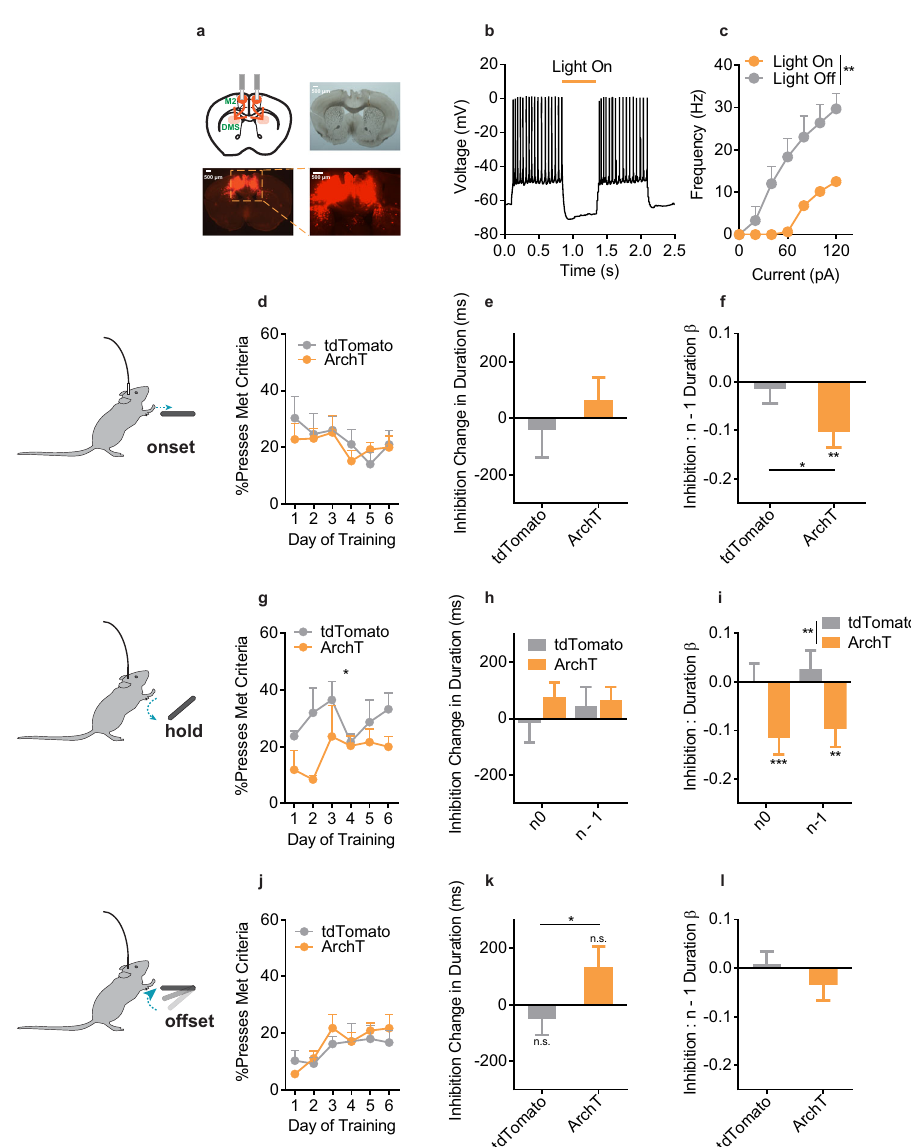
Fig. 7 Optogenetic inhibition of M2-DMS projections during execution impairs use of recent experience. a (top left) Schematic and example histology of ArchT optogenetic inhibition of M2-DMS projection neurons. b , c Slice veri fi cation of ArchT-mediated inhibition in M2-DMS projection neurons. ** = 2- way RM ANOVA (Current x Light) interaction: F 6,6 = 17.0, p = 0.002. d – f Pre-onset inhibition. d %Presses that met criteria, ( e ) Main effect of inhibition on duration, and ( f ) Interaction between inhibition and the contribution of the prior duration. g – i As in ( d – f ) except for inhibition during the duration of the press. In ( g ), a 2-way RM-ANOVA (Opsin/Fluorophore X Day) revealed a main effect only of Opsin group (F 1,9 = 7.59, p = 0.0223), and in ( i ), a 2-way RM ANOVA (Opsin/Fluorophore x n-back) revealed a main effect only of Opsin group (F 1,23602 = 10.5, p = 0.0012). j – l As in ( d – f ) except for inhibition occurring after press offset. Note that although there is a group difference between ArchT and tdTomato mice in ( k ), the main effect itself is n.s. in the model for both groups. All tests were two-tailed and multiple comparisons corrected. n0 = Light occurred on press n. n - 1 = Light occurred on press n - 1. tdTomato = tdTomato expressing control mice. ArchT = ArchT expressing mice. In all LME graphs, * without any lines indicate signi fi cant terms via F-test on the model (within group comparison), while * with a line indicate signi fi cant, between group differences. *** p < 0.001, ** p < 0.01, * p < 0.05. n.s. = Not signi fi cant. Data are mean + SEM. See also, Source